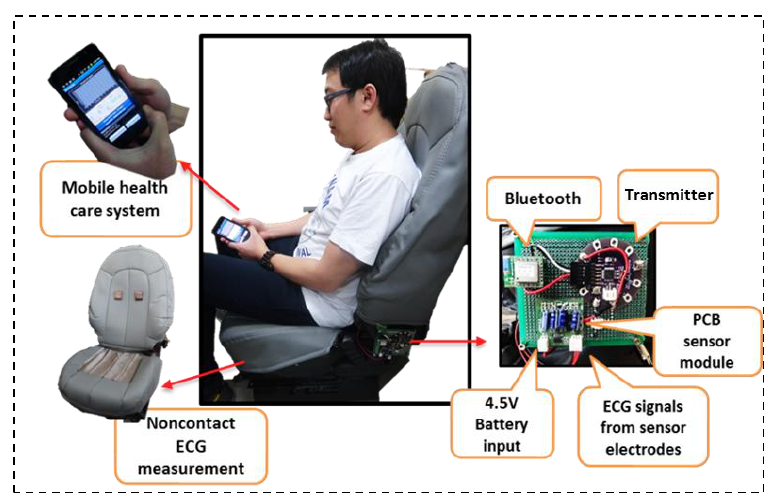
Figure 11. Setup of the ECG real-time monitoring